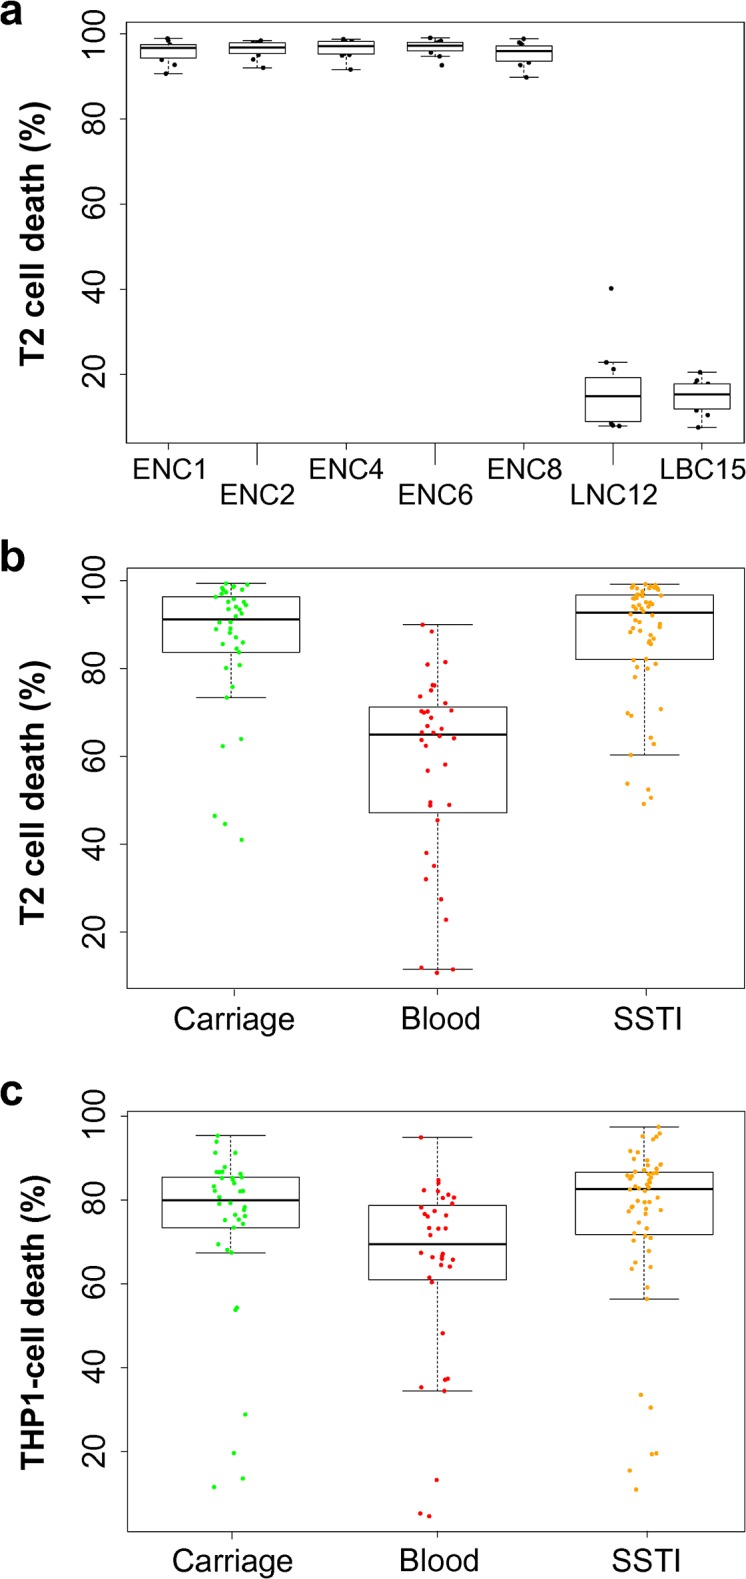
Low levels of toxicity are associated with invasive S. aureus infections across two collections of clinical isolates.
a: Individual isolates from seven time points were assayed for toxicity and their genome sequenced. Early nose cultures (ENCs) from months 1, 2, 4, 6, and 8 were all highly toxic. Late nose culture (LNC) isolates at month 12 and bloodstream isolates following bacteraemia (late blood culture, LBC) were all significantly less toxic than the ENC isolates. b and c: The toxicity of 134 USA300 isolates were assayed, and those from bacteraemia were on average significantly less toxic (measured as percent T2 and THP1 cell death (b and c, respectively)) than from carriage or SSTI (p < 0.01 ANOVA). The medians are presented as horizontal bars, with the boxes and whiskers showing the 1st and 3rd quartile and interquartile ranges. To access this data, see S1 Data.